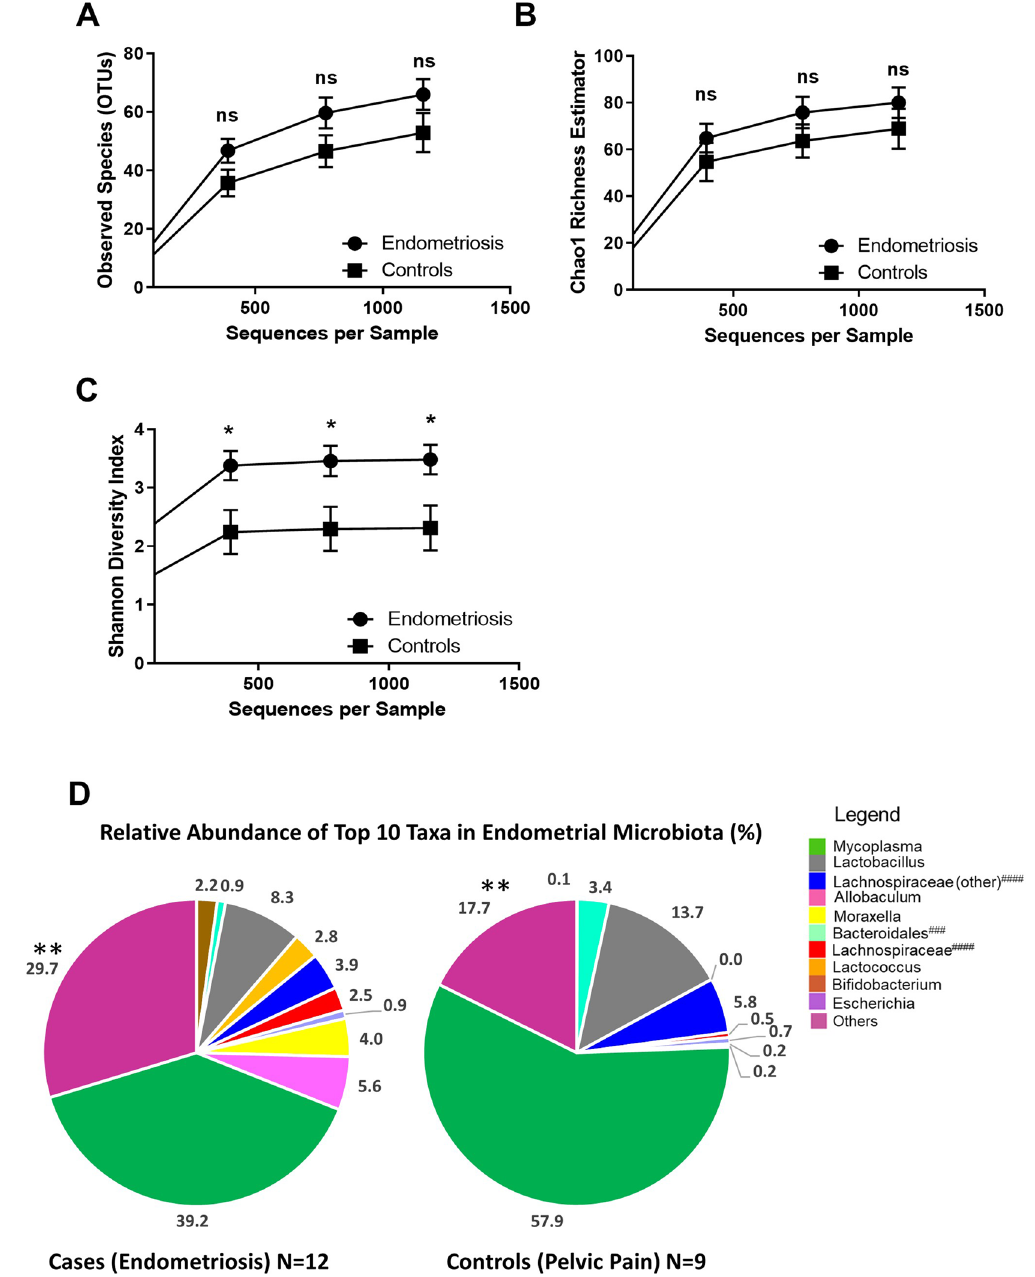
Figure 1. Endometrial microbiota of patients with endometriosis is significantly more diverse than symptomatic controls. Three alpha-diversity metrics were used to compare bacterial richness and evenness within the endometrial microbiota of patients with surgically confirmed endometriosis (N = 12) and surgically confirmed controls (with pelvic pain, but not endometriosis, N = 9). ( A ) No significant differences in Observed Species or ( B ) Chao 1 Richness were observed at the levels of rarefaction where graphs levelled off and the greatest number of samples was retained (multiple unpaired t-tests, corrected for multiple comparisons using the Holm–Sidak method). ( C ) Patients with endometriosis had significantly greater bacterial diversity as assessed by the Shannon Diversity Index at all levels of rarefaction where the graph levelled off and the greatest number of samples was retained (adjusted p ≤ 0.05; multiple unpaired t-tests, corrected for multiple comparisons using the Holm–Sidak method). ( D ) The average percent relative abundance of the top 10 taxa in the endometrial microbiota of cases and controls was plotted as a pie chart and the proportion of taxa assigned to the ‘Others’ category was significantly greater in patients with endometriosis than symptomatic controls (unadjusted p = 0.007; adjusted p = 0.07, Mann–Whitney U test without/with correction for multiple comparisons using the Holm–Sidak method). * p ≤ 0.05, ** p ≤ 0.01. Data is presented as mean ± SEM ( A–C ) and as a percentage ( D ). Ns: not significant. OTUs: operational taxonomic units. ###: resolved to bacterial order, ####: resolved to bacterial